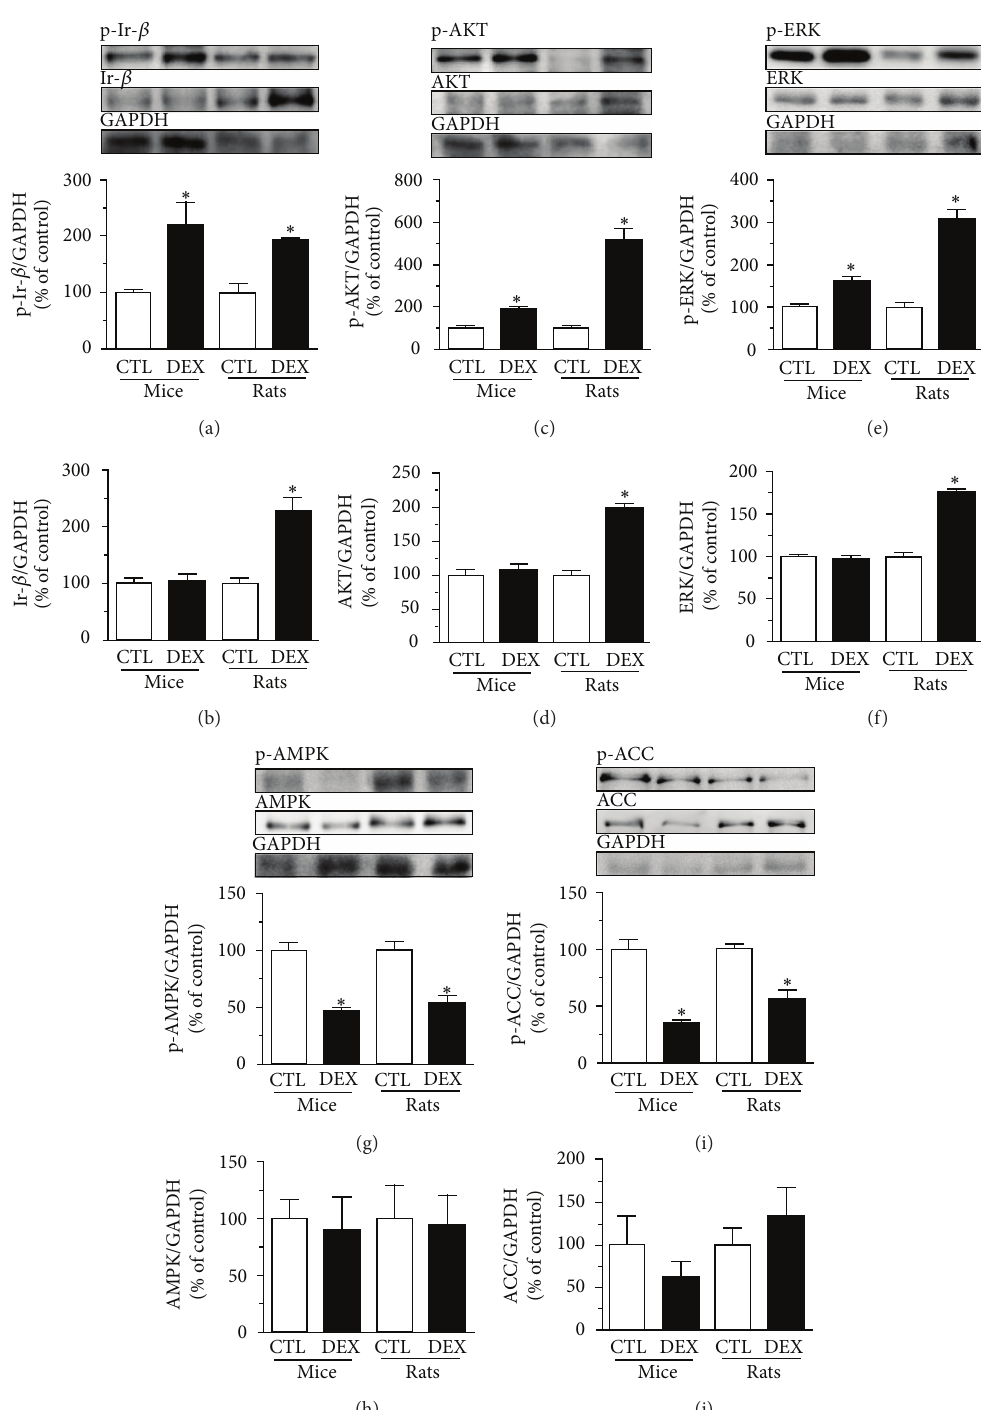
Figure 5: DEX treatment stimulates the canonical insulin pathway and inhibits the noncanonical insulin pathway in pancreatic islets from miceandrats. (a)Representativeimmunoblottingofphosphorylatedand(b)totalIr- 𝛽 content.(c)Phosphorylatedand(d)totalAKTcontent. (e) Phosphorylated and (f) total ERK content. (g) Phosphorylated and (h) total AMPK content. (i) Phosphorylated and (j) total ACC